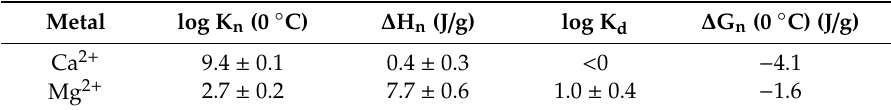
Table 1. The parameters of Ca 2 + and Mg 2 + binding by bovine α -lactalbumin estimated according to the Scheme 1, using global fitting